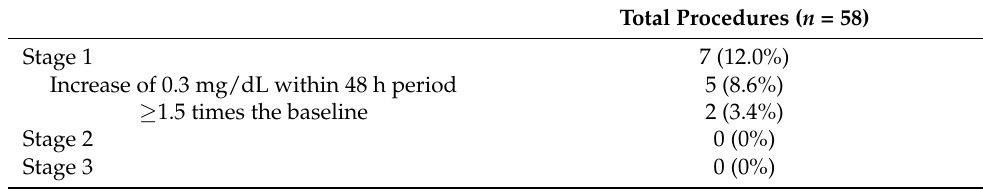
Table 4. Acute kidney injury.